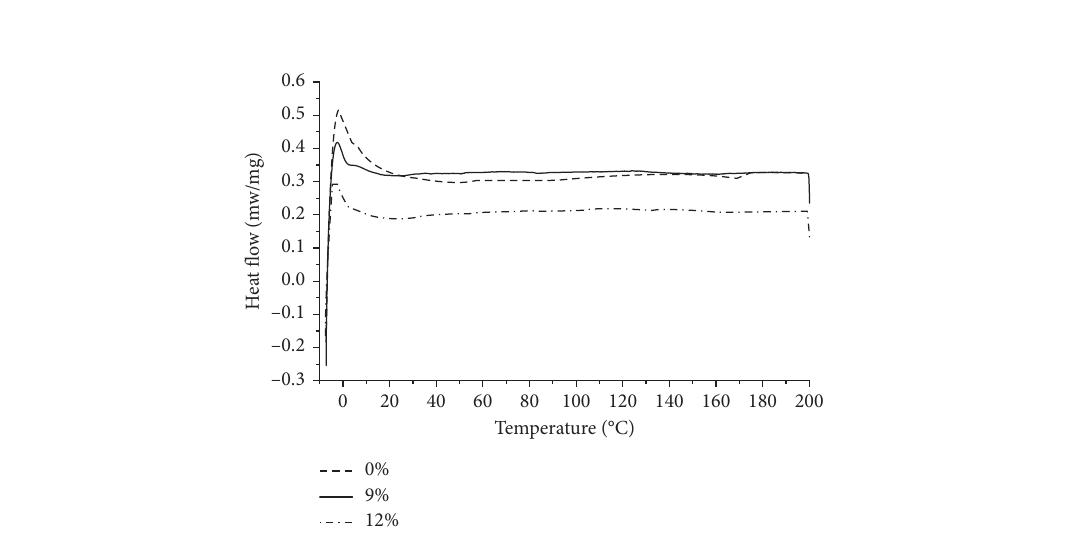
Figure 3: DSC curve of asphalt with different powder:oil ratios. Table 5: DSC endothermic peak data of asphalt.